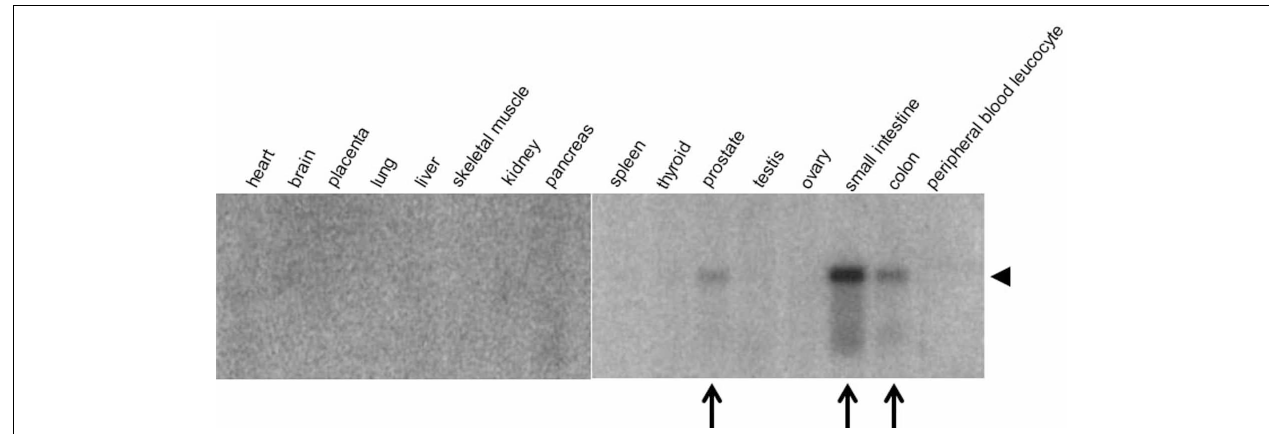
FIGURE 5 | Tissue-specific expression of OLFM4. A radiolabeled oligonucleotide probe was hybridized to a Northern blot containing mRNA from human tissue samples. Note the specific expression of OLFM4 (arrowhead) in prostate, small intestine, and colon (arrows). Modified from Kulkarni et al. (2000).